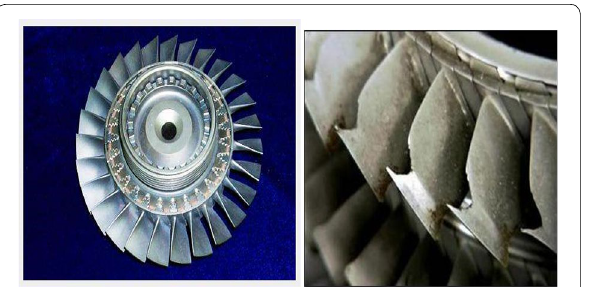
Figure 14 Physical drawing of turbine blade